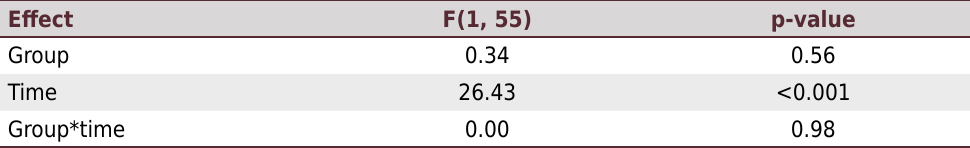
Table 4. A repeated-measure two-way analysis of variance (ANOVA) for attitude toward soil Effect